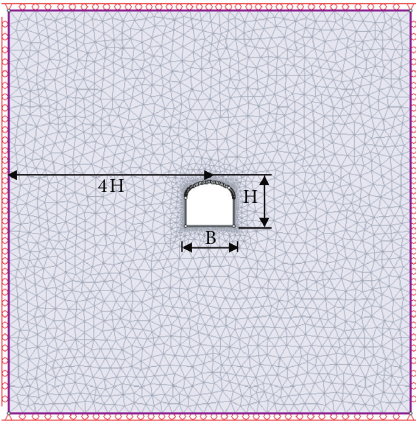
Figure 7: The model’s meshes, geometry, and boundary shape and height of falling are in accordance with the result obtained from the field observation in Figures 3 and 4.